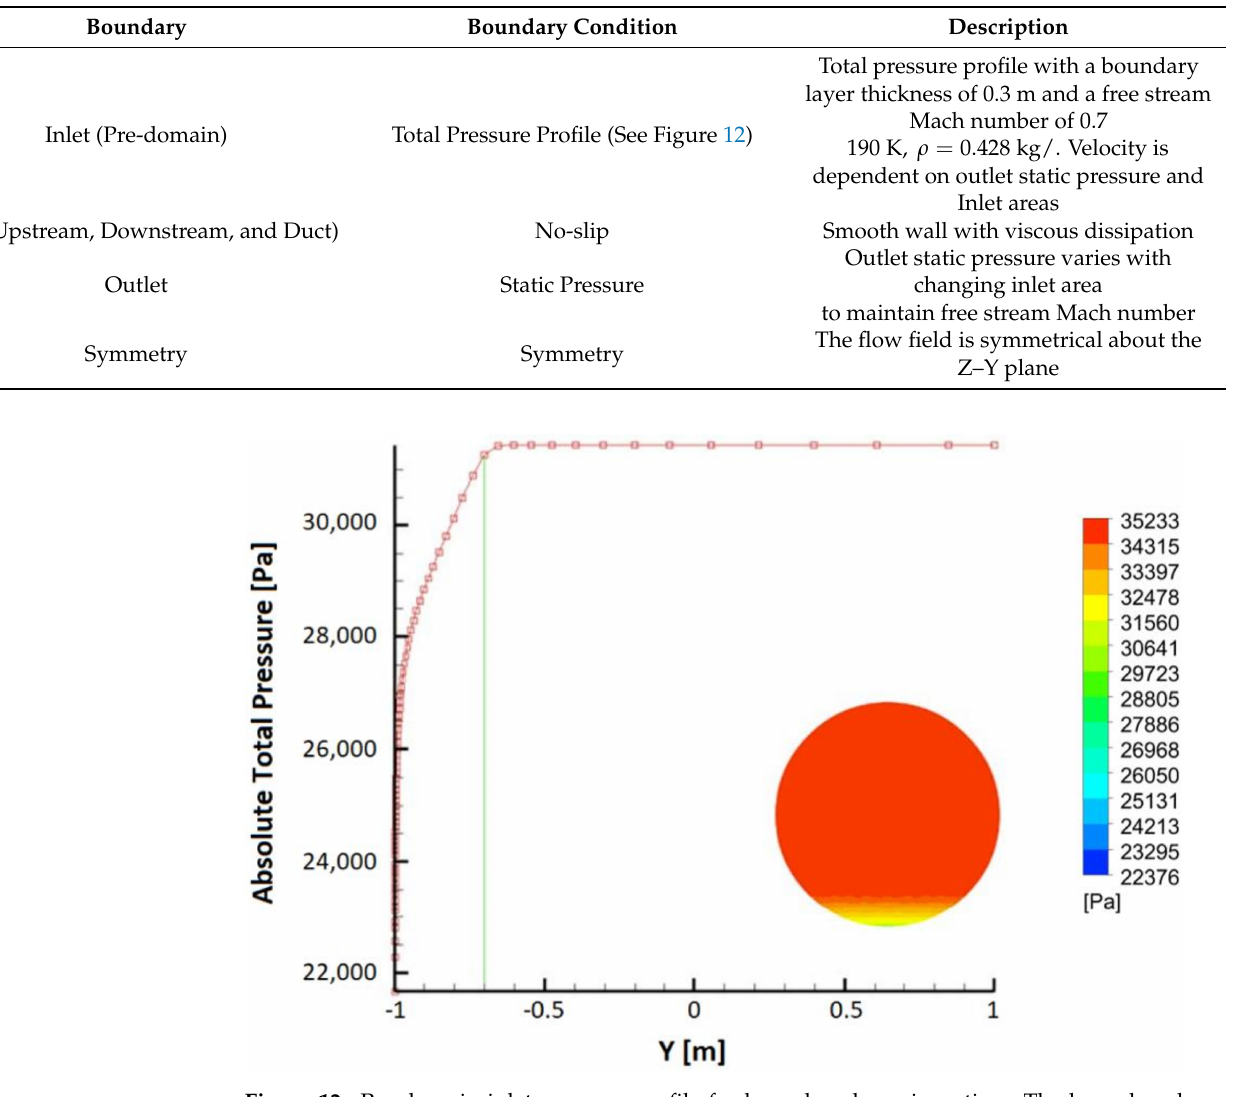
Figure 12. Pre-domain inlet pressure profile for boundary layer ingestion. The boundary layer thickness of 0.3 m is marked in